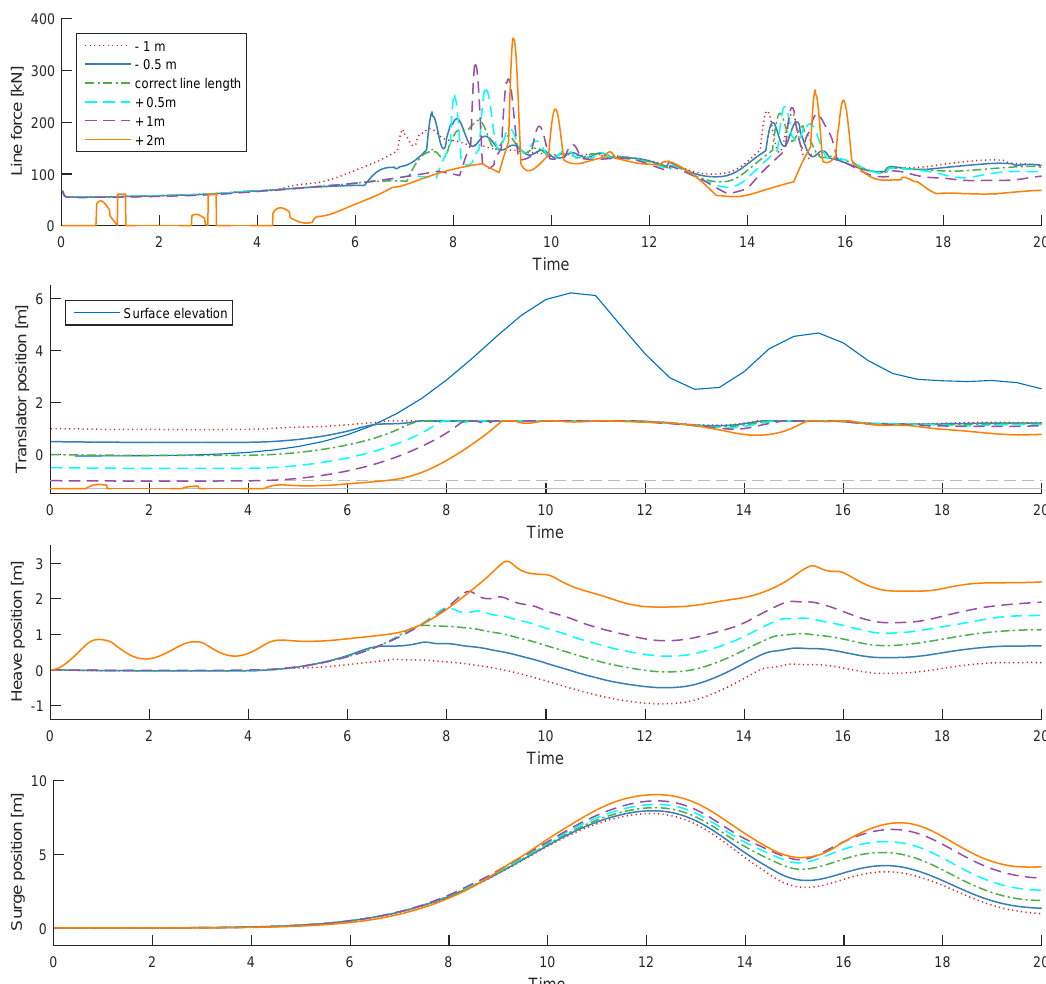
Figure 16. Line force, translator position and buoy position when the WEC is impacted by a tsunami wave. The influence of line length is compared.